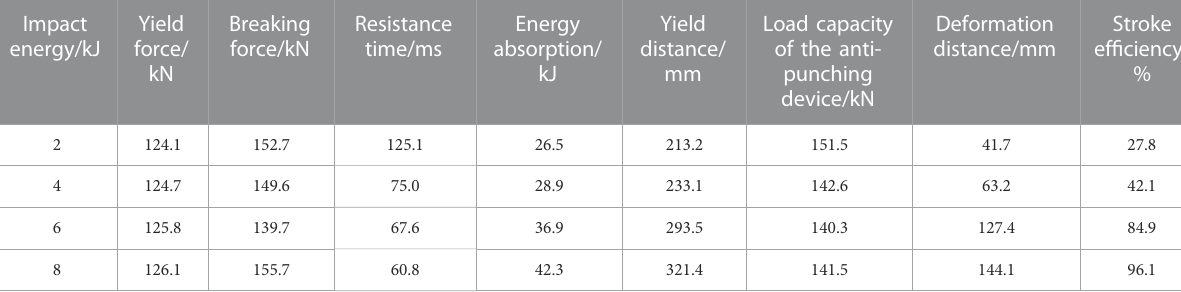
Resistance time/ms